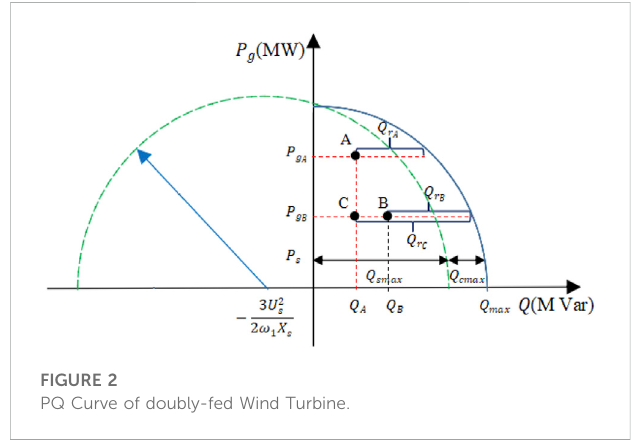
FIGURE 2 PQ Curve of doubly-fed Wind